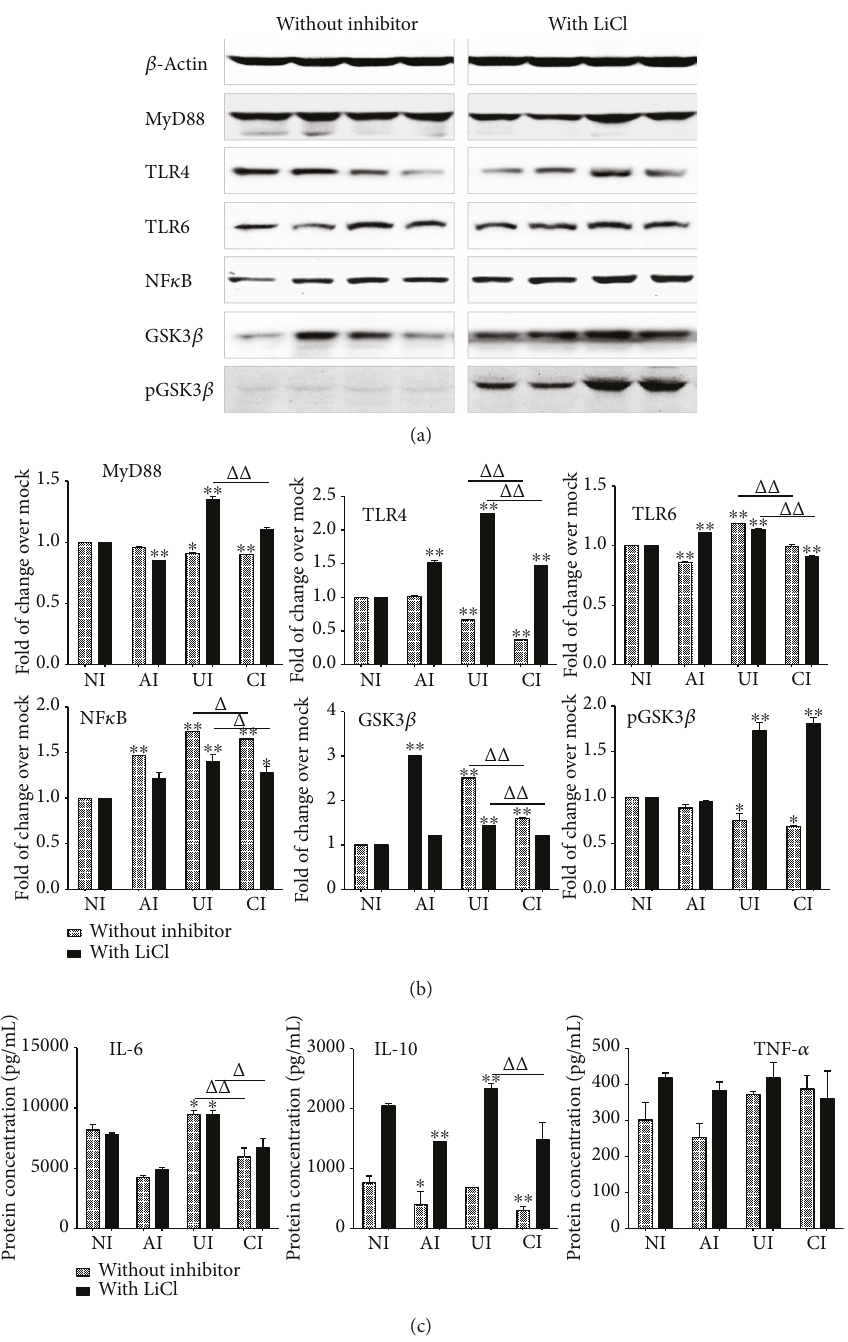
Figure 7: Impact of GSK3 β on the expression of TLR ligands and elements of the TLR signaling pathway in U937 cells to Mtb H37Rv infection in the A549 cell coculture model. In the presence or absence of GSK3 β inhibitor LiCl, the coculture model of A549/U937 cells was infected with H37Rv mycobacteria from the upper chamber (A549 cells, AI), lower chamber (U937 cells, UI), or both chambers (A549 and U937 cells, CI) at a MOI of 3 for 18 h before the culture medium and U937 cells were harvested for analysis. (a) Representative blots of immunoblotting assay for indicated components of TLR signaling cascade showed an activated TLR signaling in U937 cells of the coinfection model in the presence of LiCl, in comparison with the absence of an inhibitor. (b) The fold of changes of proteins of interest in (a) semiquantitatively determined by densitometric assay using ImageJ software Fiji from three independent experiments. (c) Concentrations of TNF- α , IL-10, and IL-6 in culture media determined by ELISA. An augmented cytokine production was observed in the presence of GSK3 β inhibitor LiCl, but the trend of a reduced TLR-mediated in fl ammatory response was not altered by the addition of LiCl. Error bars represent the standard deviation (SD) from three independent experiments. Compared to noninfection (NI) control, ∗ p < 0 05 and ∗∗ p < 0 01 ; compared to the absence of LiCl, Δ p < 0 05 and ΔΔ p < 0 01 . NI: noninfected control; AI: infection was performed on A549 cell alone; UI: infection was performed on U937 alone; CI: infection was performed on both A549 cells and U937